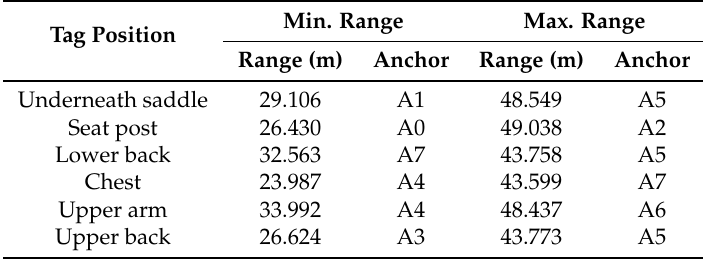
Table 4. Range (m) for all tag